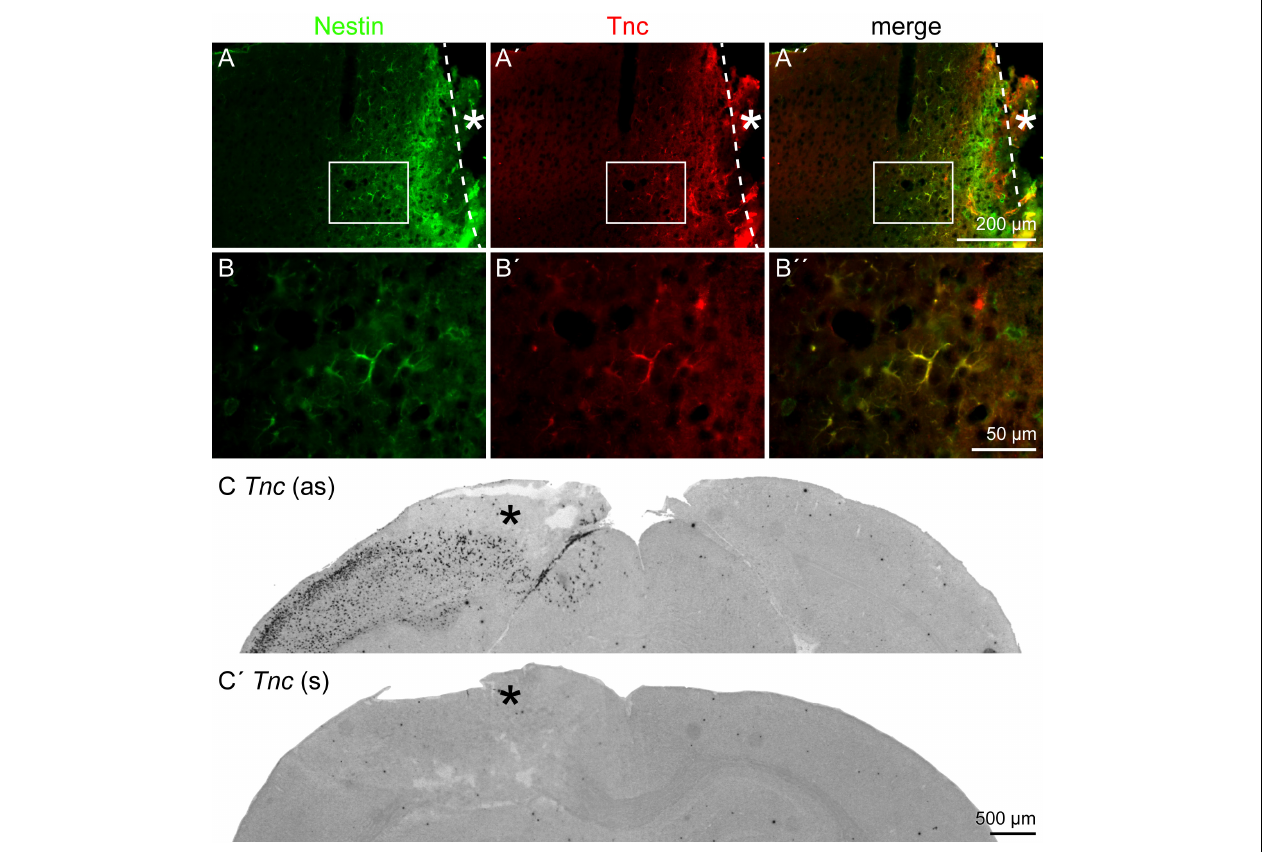
FIGURE 6 | Tnc expression by reactive astrocytes, 3 dpl. (A–B (cid:48)(cid:48) ) Tnc was expressed by nestin-positive reactive astrocytes in the penumbra. (B–B (cid:48)(cid:48) ) Higher magnifications of the boxed region in A–A (cid:48)(cid:48) . (C,C (cid:48) ) In situ hybridization revealed a prominent re-expression of Tnc mRNA in the lesioned cortex, whereas no expression was found on the contralateral side. The sense riboprobe (s), used as a negative control, showed no unspecific staining. Asterisk: lesion core; scale bars: 200 µ m (A–A (cid:48)(cid:48) ) , 50 µ m (B–B (cid:48)(cid:48) ) , 500 µ m (C,C (cid:48) )